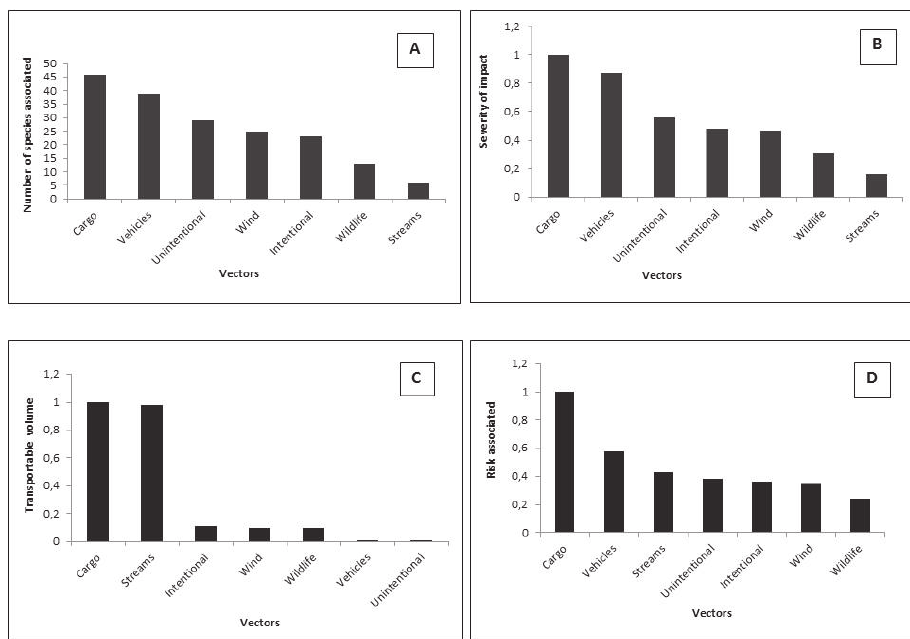
Figure 2. Vectors of introduction and spread of invasive and potentially invasive alien plants present in intensive use zones of the Ernesto Tornquist Provincial Park and it’s surroundings (Buenos Aires, Argen- tina). A Number of species associated to each dispersion vector according to the characteristics of their fruits and seeds and their human use B Severity of impact of vectors depending on the potential impact of transportable species and the difficulty of their control C Relative capacity of vectors to transport propagules D Risk associated with vectors depending on the potential impact of transportable species, the difficulty of their control and the transport capacity of the